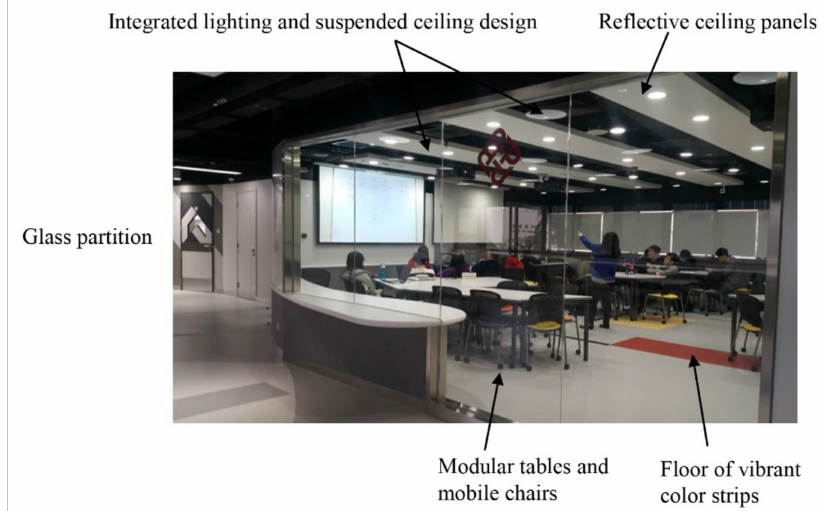
Figure 2. Refitting of classroom